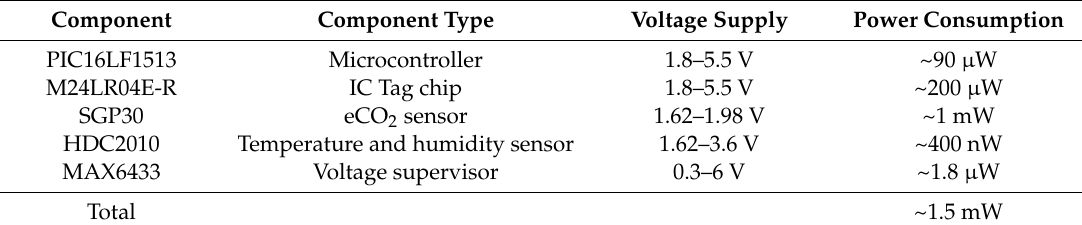
Table 2. Average power consumption of the smart sensor tag operating.